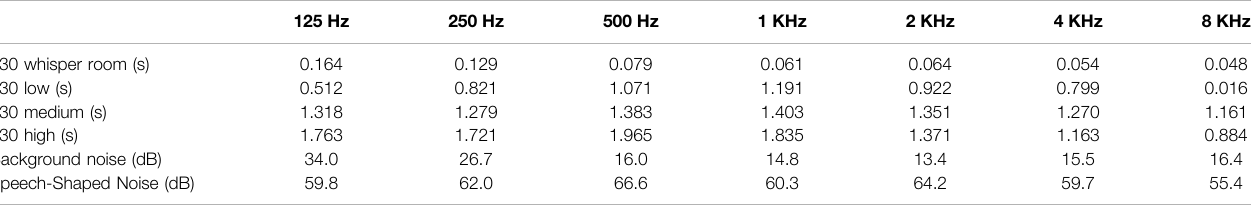
TABLE 1 | T30 measured in Whisper Room conditions and 3 simulated environments (Low, Medium, and High) per octave band. Background noise conditions with and without speech-shaped noise spectrum per octave band. 125 Hz 250 Hz 500 Hz 1 KHz